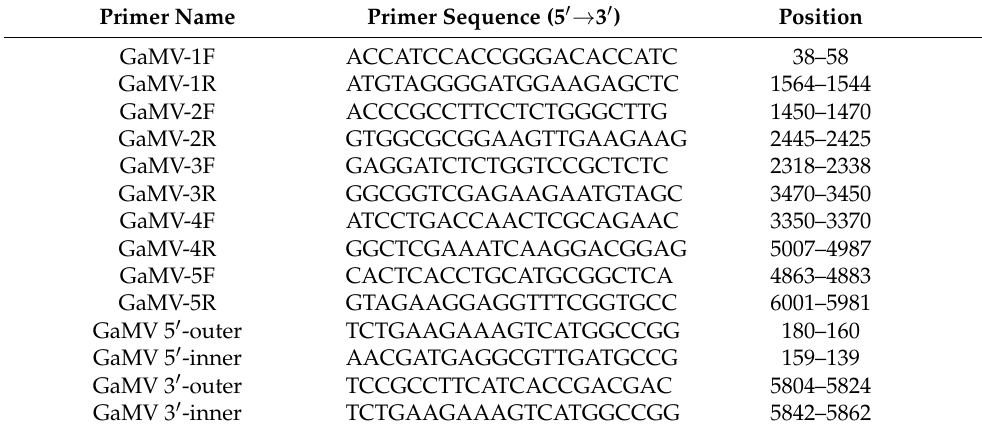
Table 3. Primers designed for PCR amplification of the grapevine-associated marafivirus (GaMV)